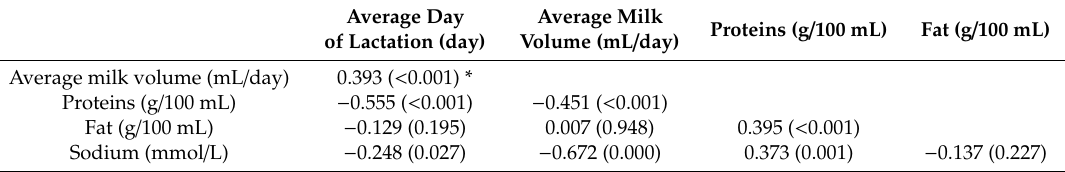
Table 2. Correlations between milk volume, macronutrient, and sodium